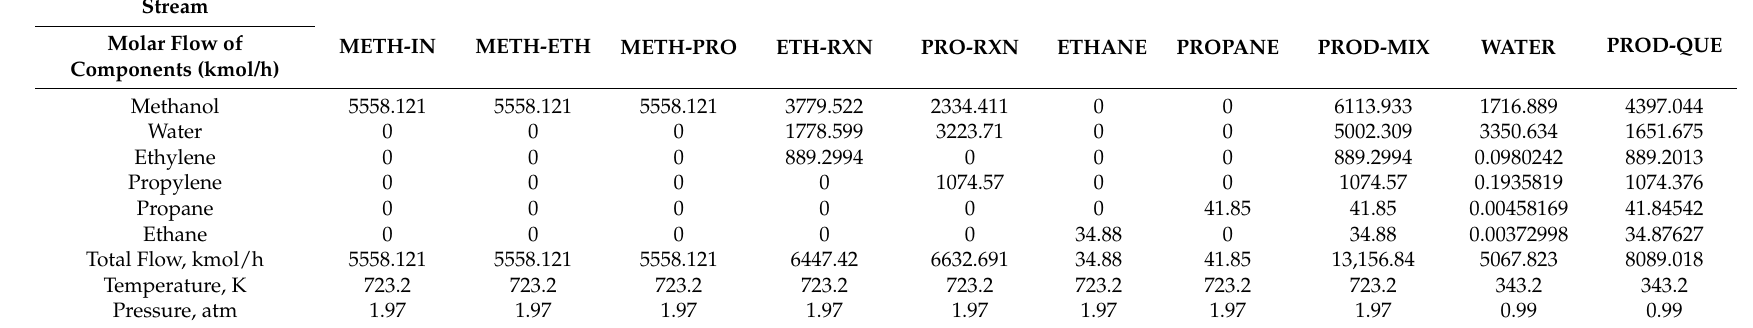
Table A1. The stream data for the methanol to olefins (MTO) process.